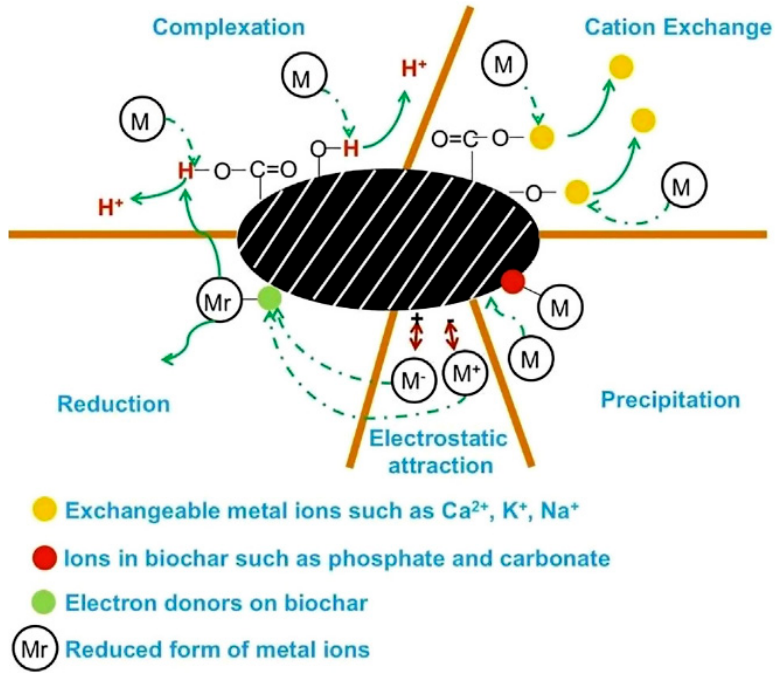
Figure 2. Mechanism of adsorption of heavy metals by biochar [45] (Reproduced with permission from Li et al., Chemosphere, published by Elsevier, 2017).